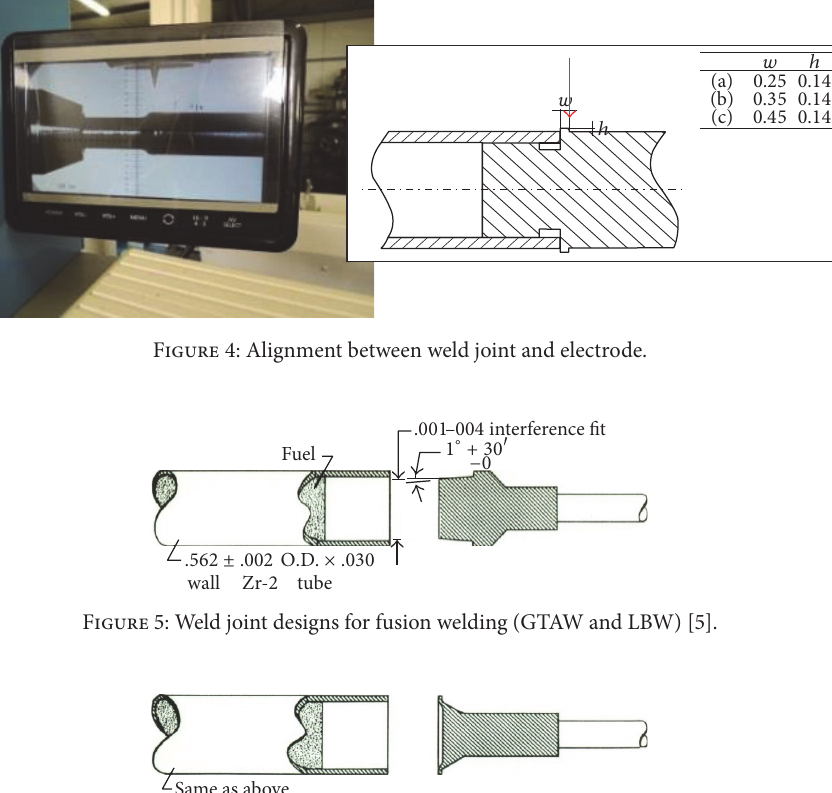
Figure 6: Weld joint designs for solid state welding (RW)